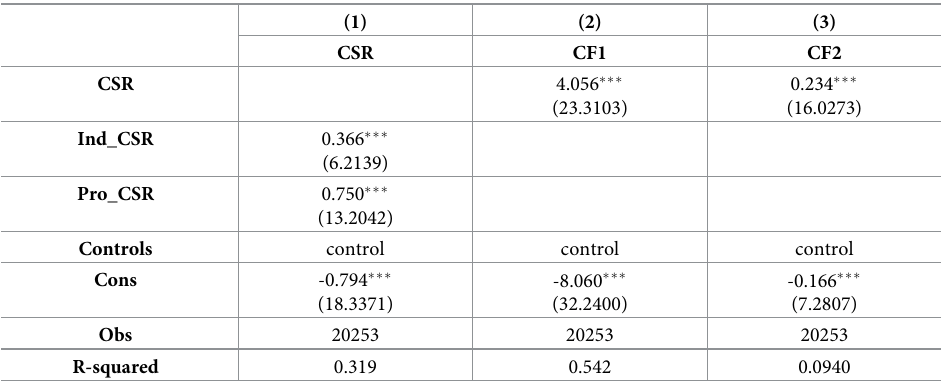
Table 8. Endogeneity test: 2SLS